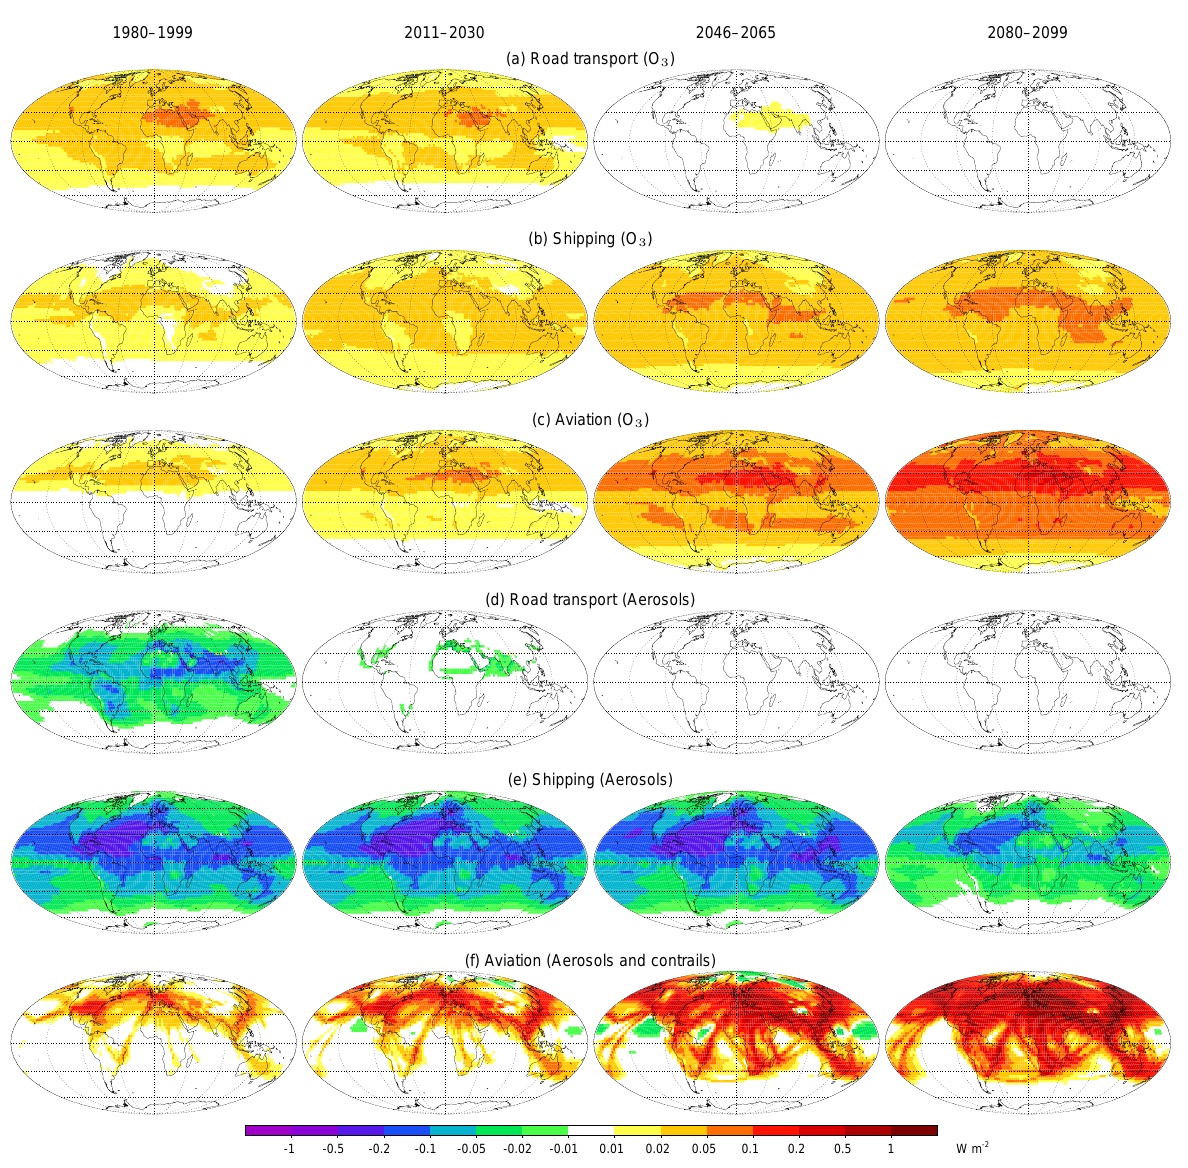
Fig. 8. Global maps of the annual mean impact on the net TOA forcing in the periods 1980–1999, 2011–2030, 2046–2065 and 2080–2099 by O 3 perturbations from (a) road transport, (b) maritime shipping and (c) aviation, by aerosols from (d) road transport and (e) maritime shipping, and (f) by aerosols and contrails from aviation.